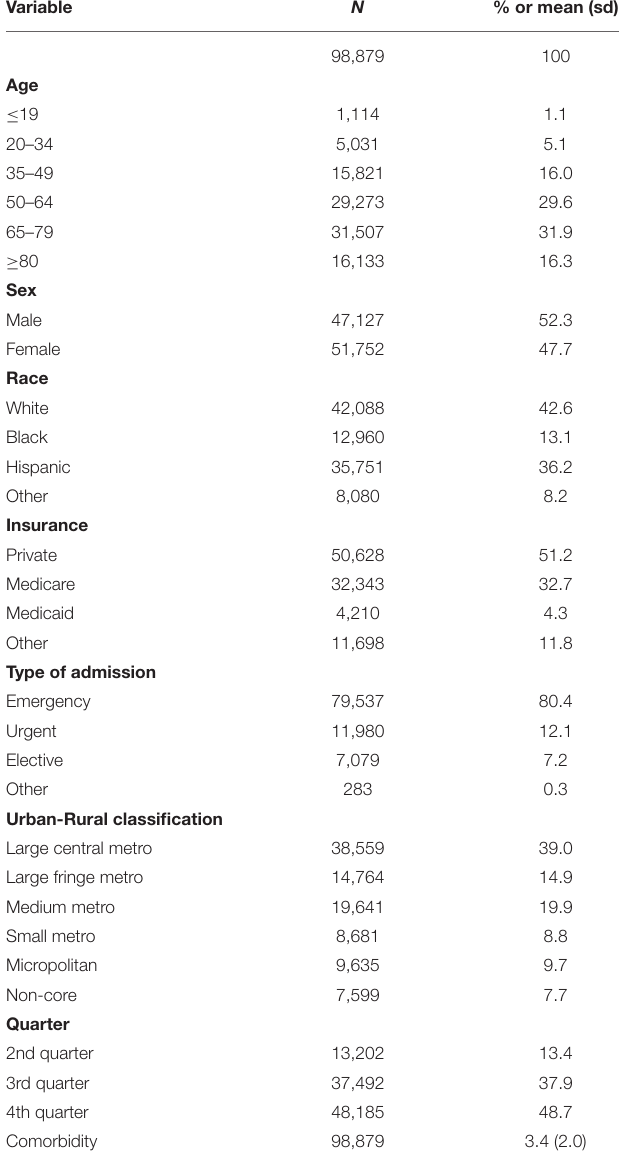
TABLE 1 | Characteristics of patients hospitalized with COVID-19. TABLE 2 | Summary of LOS, ICU admission, and in-hospital death by age, sex, and race/ethnicity among patients hospitalized with